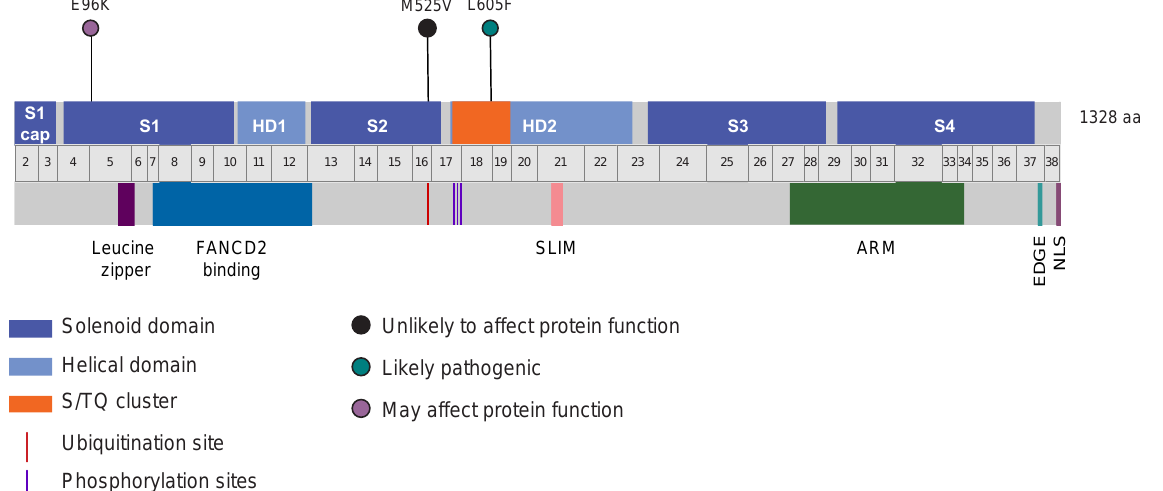
Figure 2. Schema showing location of variants in FANCI gene and protein identified from ClinVar using the established criteria for c.1813C>T; p.L605F. FANCI domains were adapted from